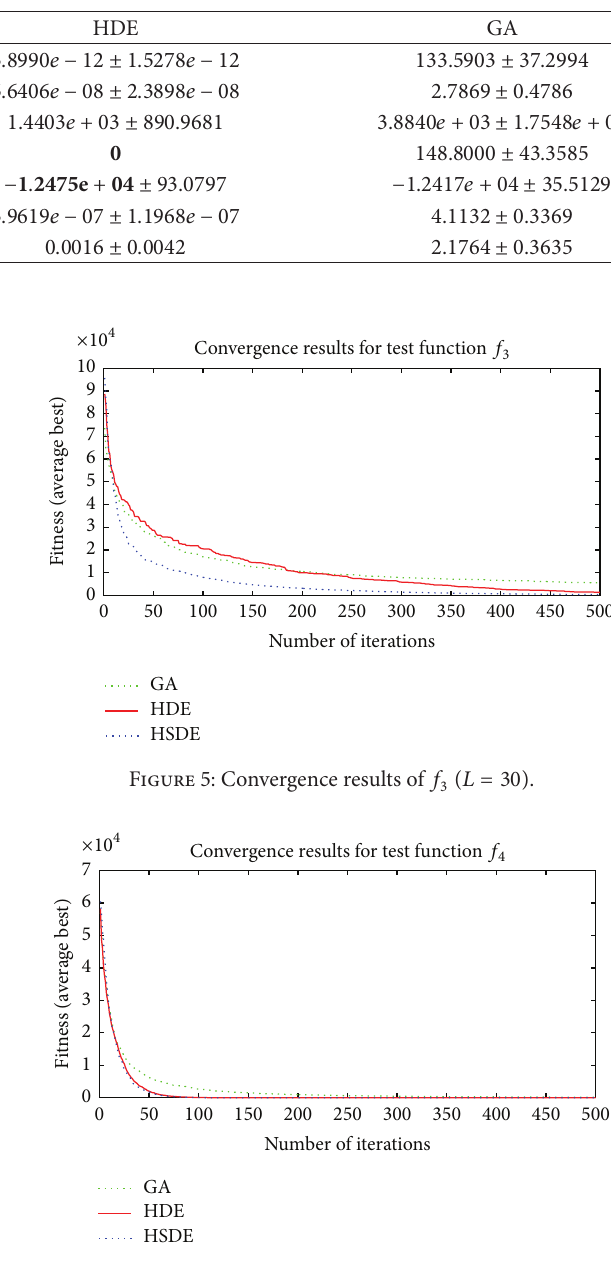
Figure 6: Convergence results of 𝑓 4 ( 𝐿 = 30